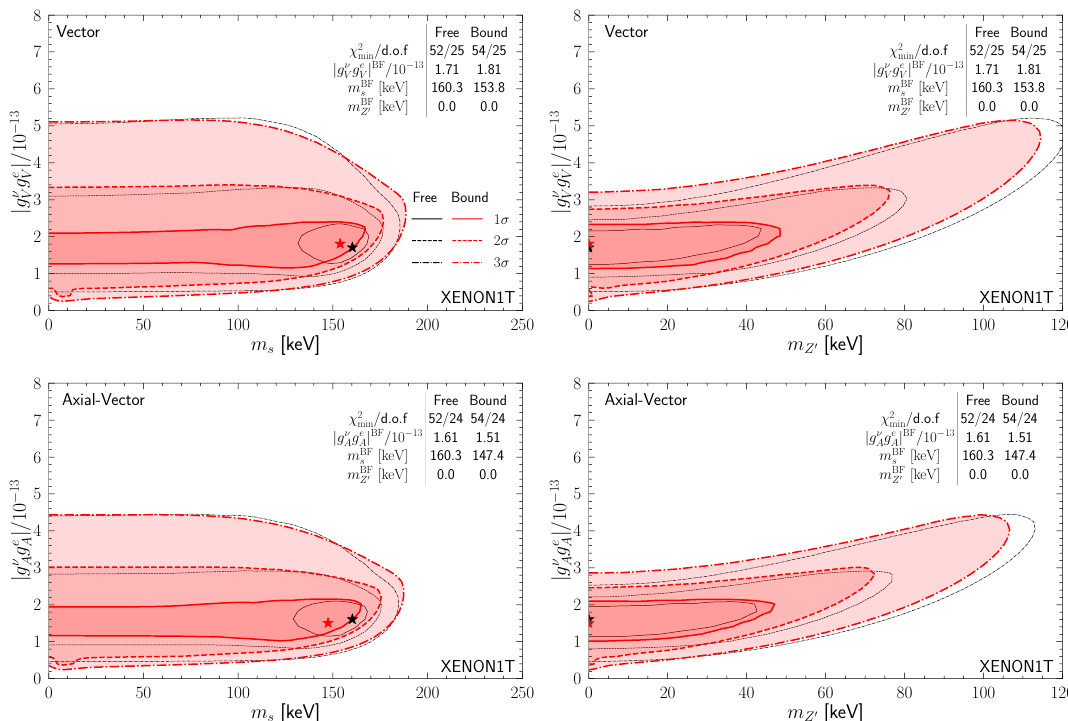
Figure 8 . The XENON1T constraints for vector (up), axial-vector (bottom) interaction couplings | g ν g e | versus m s (left) and m φ (right) at 1 , 2 and 3 σ C.L. The same as before, black curves are V,A V,A for free electron approximation and red ones for bound electron scenario. Their best-fit values are indicated with black (free) and red (bound) stars. The mediator (sterile neutrino) mass m Z 0 ( m s ) is marginalized over 0 keV < m Z 0 < 175 keV ( 0 keV < m s < 250